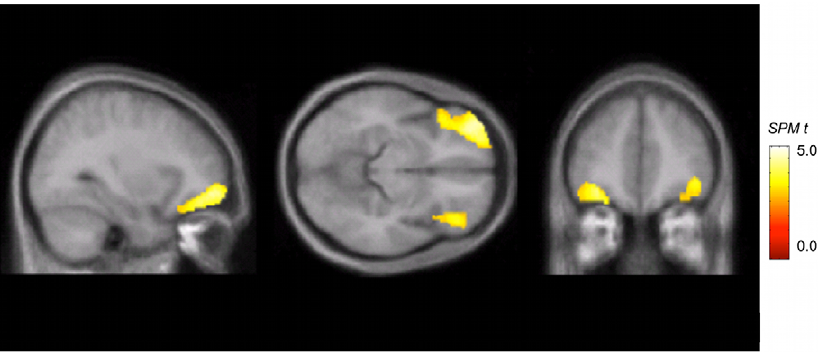
Figure 2. Statistical Parametric Mapping of 11 C-AMT Plasma-to-Brain clearance. The figure represents a comparison between young adults with a high physical aggression trajectory during elementary school and desisted during adolescence (C-LHPA) vs . those who had a more normal pattern (low) of physical aggression (LPA) ( N =26). The color-coded images indicate a marked decrease in brain serotonin synthesis capacity bilaterally in the OBFC in those subjects with the high physical aggression trajectory.